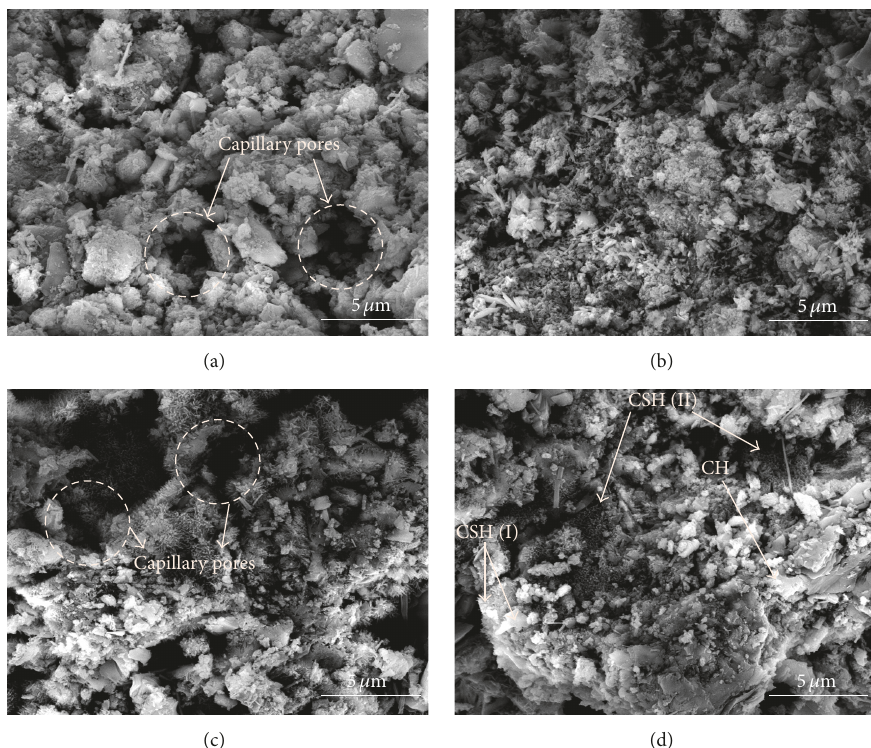
Figure 8: (a) SEM for CWM0 after 7 days of hydration; (b) SEM for HWM0.5 after 7 days of hydration; (c) SEM for CWM0 after 28 days of hydration; (d) SEM for HWM0.5 after 28 days of